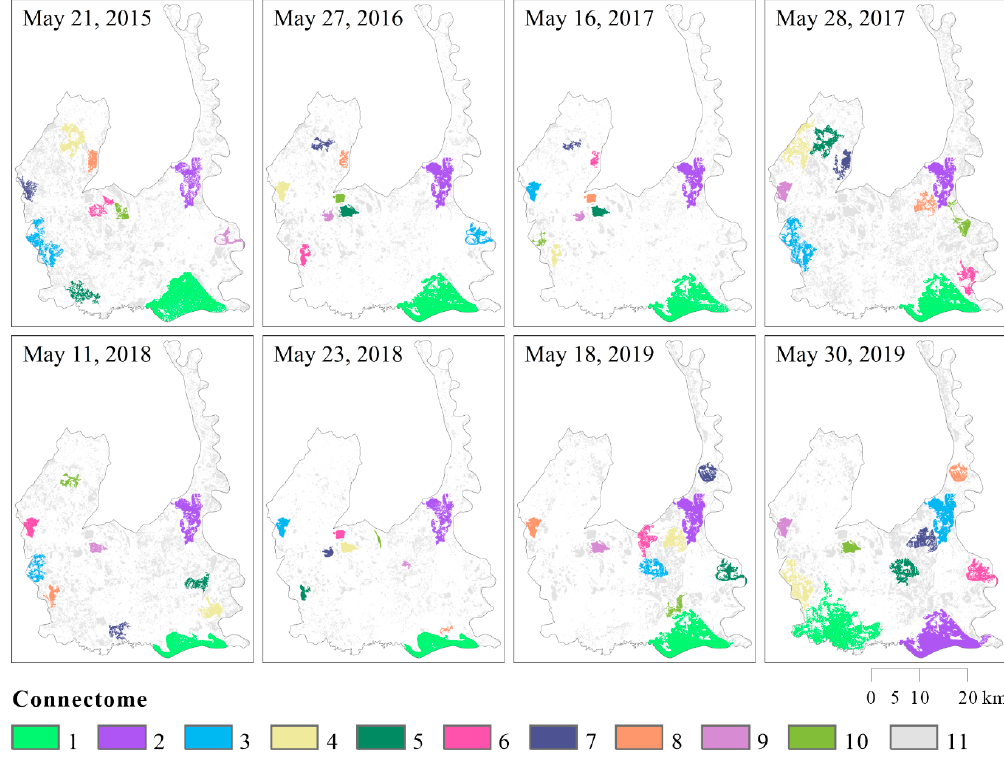
Figure 9. Spatial distribution of the connectomes (i.e., seasonally connected water bodies) in China’s Momoge National Nature Reserve in May. Colors 1 to 10 in the legend refer to the top ten largest connectomes, and color 11 refer to the remaining connectomes and isolated water bodies.